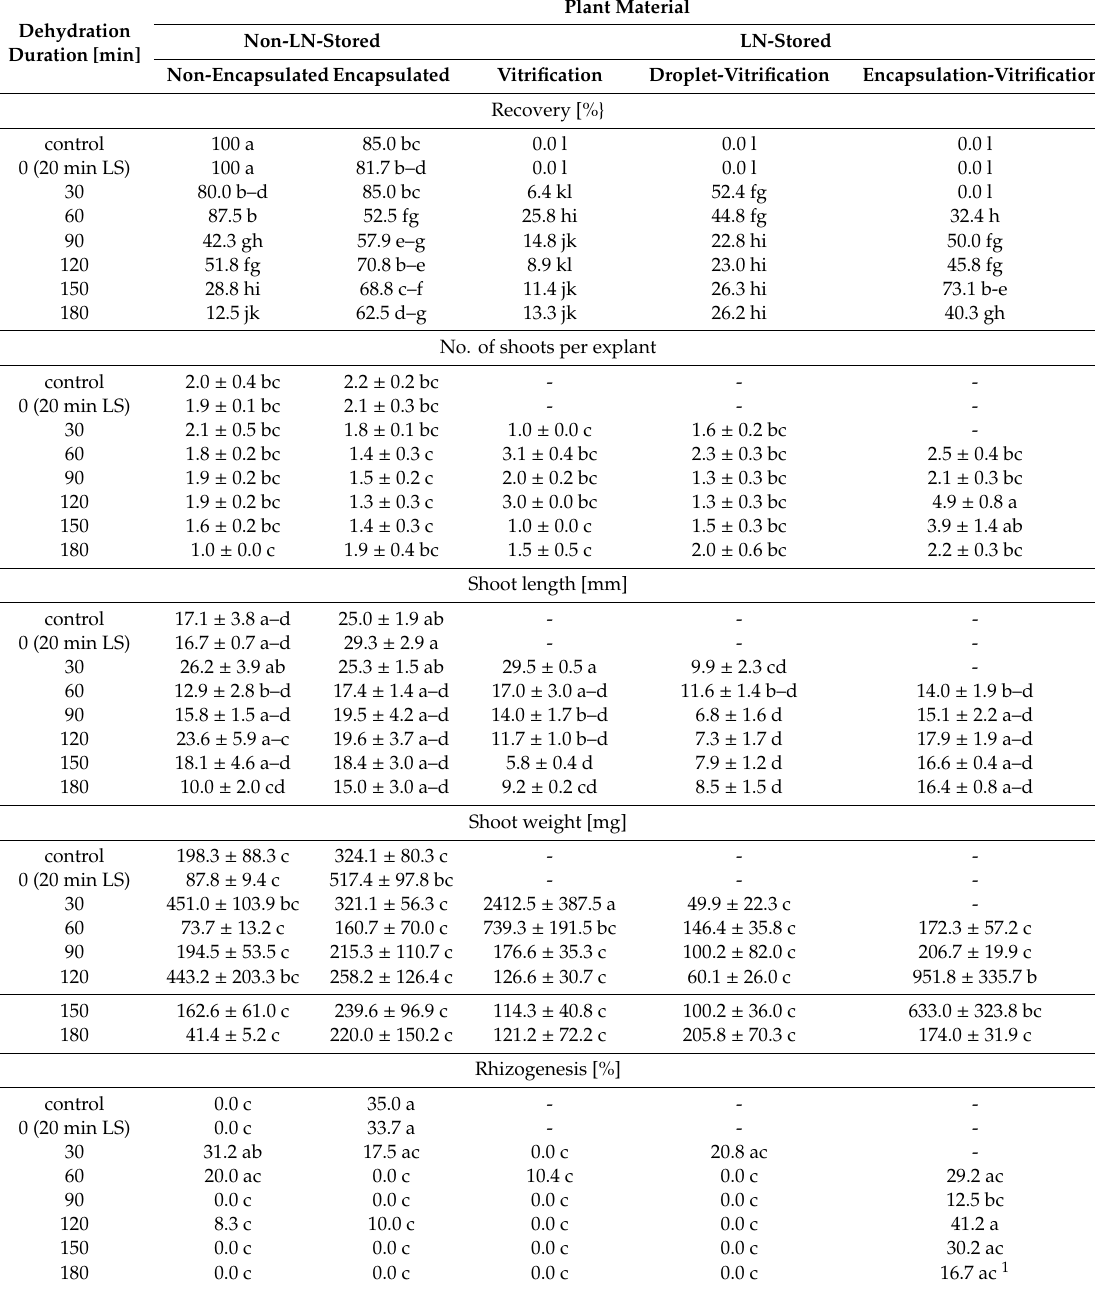
Table 1. Influence of three cryopreservation techniques on the recovery level [%], number, length [mm], and fresh weight [mg] of shoots produced from a single viable explant ( +/ − LN-stored), and their capability to form roots [%] after 60 days of recovery